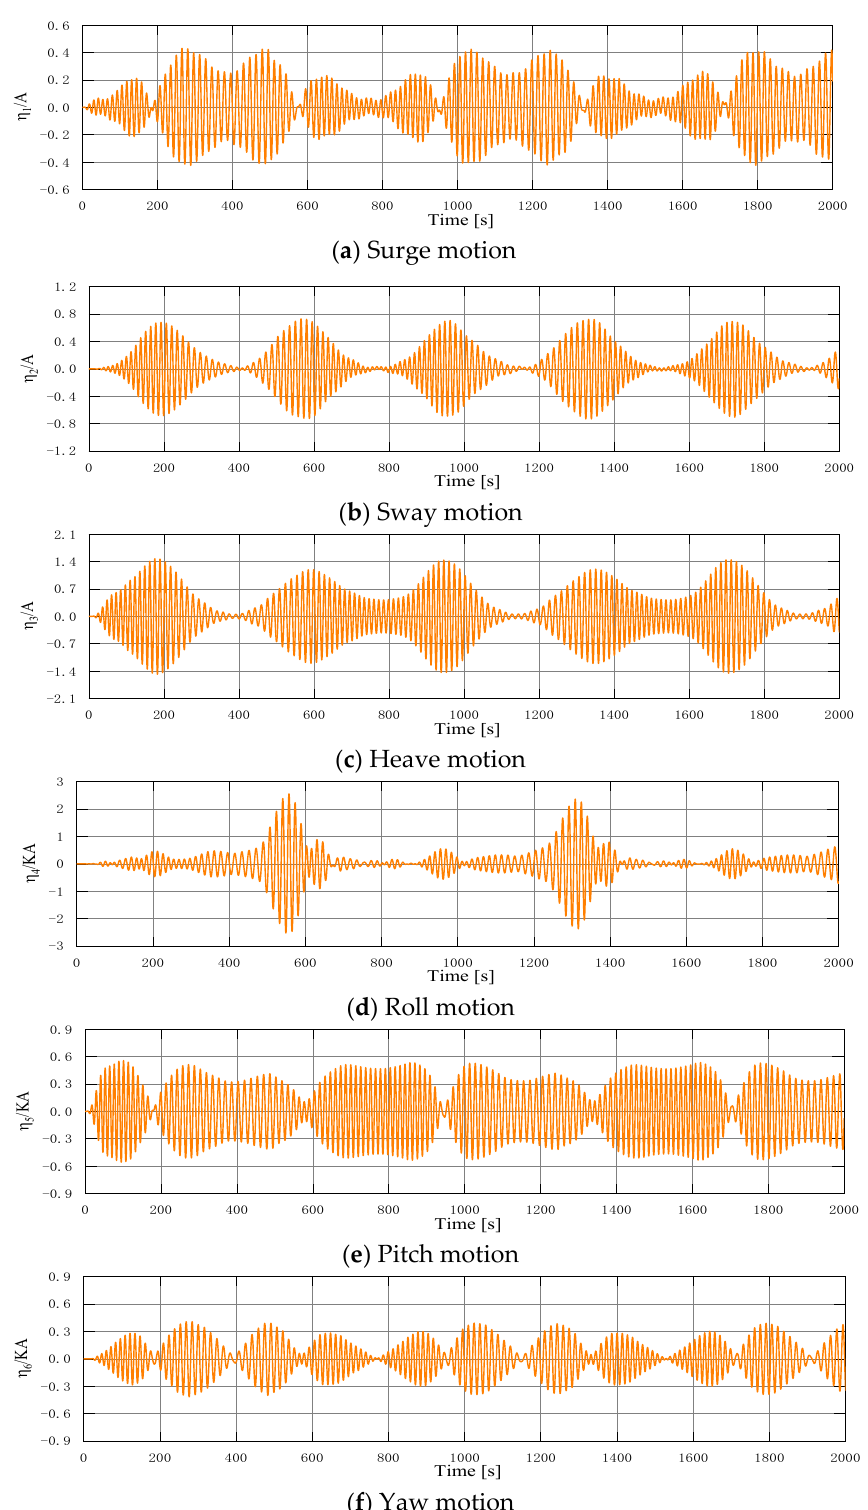
Figure 21. Surge, sway, heave, roll, pitch, and yaw motions of the KVLCC2 under +35° turns.